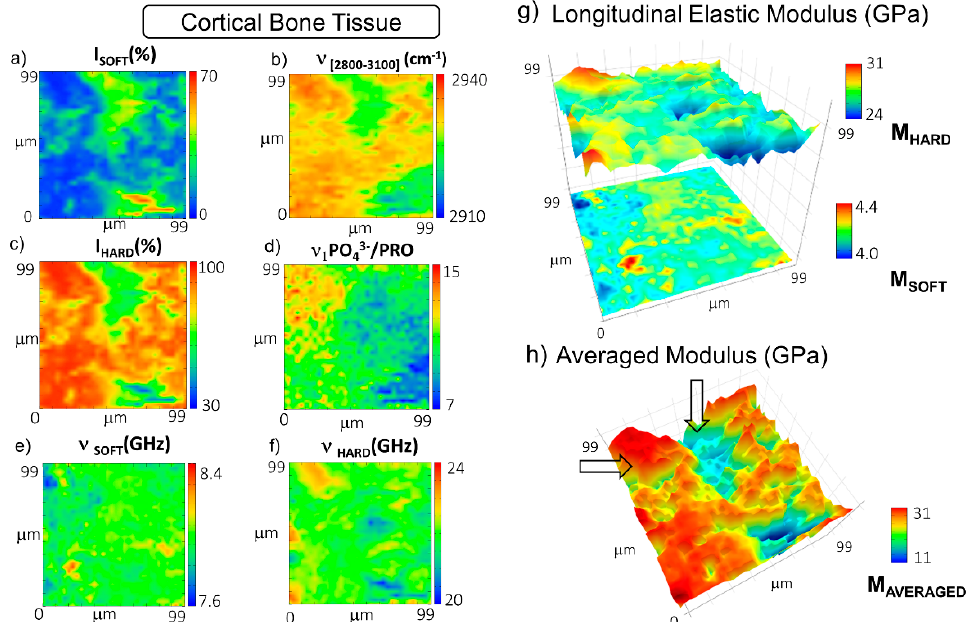
Figure 2. Maps of the distribution in the cortical bone of ( a ) the percentage of P SOFT component; ( b ) the first spectral moment of CH 2 -CH 3 signal at 2800-3100 cm − 1 ; ( c ) the percentage of the P HARD component; ( d ) the mineralization degree expressed as the relative ratio between the ν 1 PO 43- signal at 965 cm − 1 and the proline signal at 860 cm − 1 ; the frequency shifts of ( e ) the P SOFT and ( f ) the P HARD components; ( g ) stacked surface plots of the longitudinal elastic moduli of the soft and hard com- ponents (M SOFT and M HARD ); ( h ) surface plot of the average longitudinal elastic modulus (M AVERAGED ). Arrows point out areas mainly occupied by the ECM (higher values in red) and by the central blood vessel (lower values in blue).